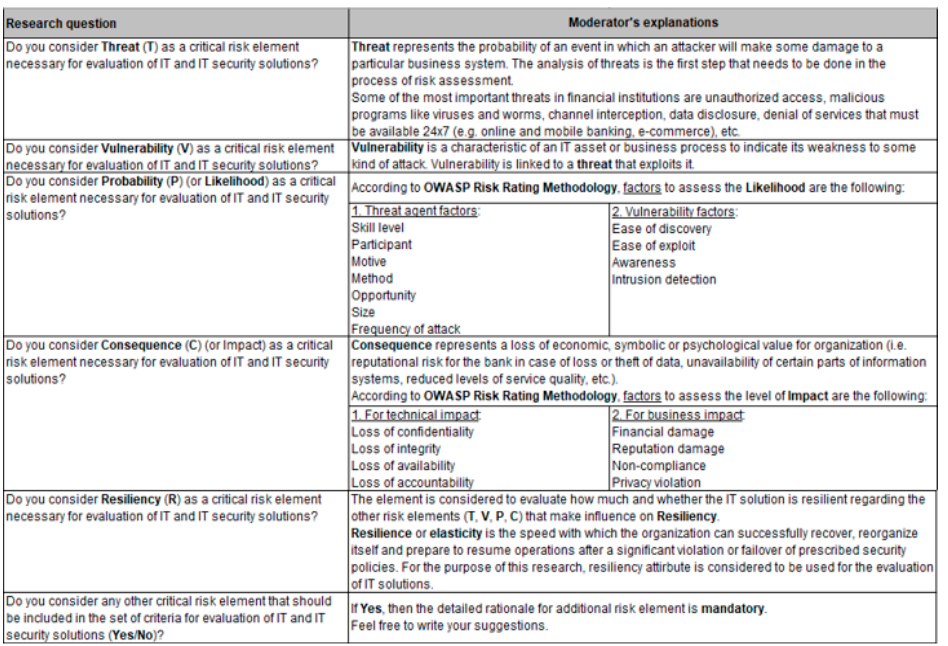
Figure A1. Research questionnaire for the first Delphi round. Five risk assessment attributes were presented for evaluation (closed questions), while one open question was included for IT security experts to consider any additional elements that could be part of the new hybrid multicriteria model.